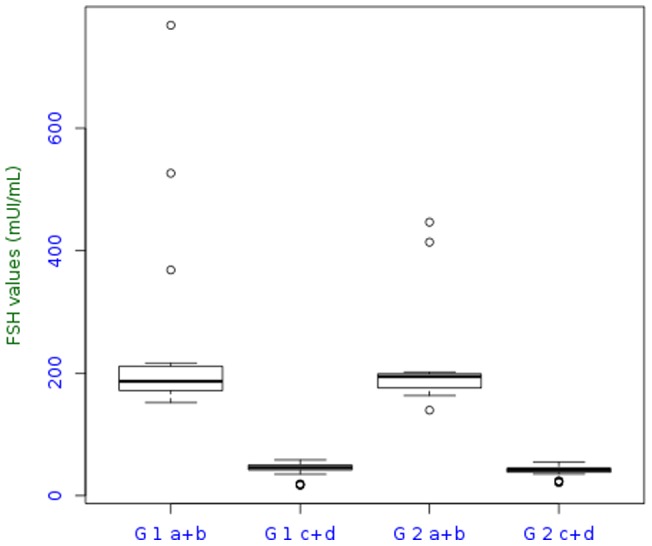
Median FSH level.